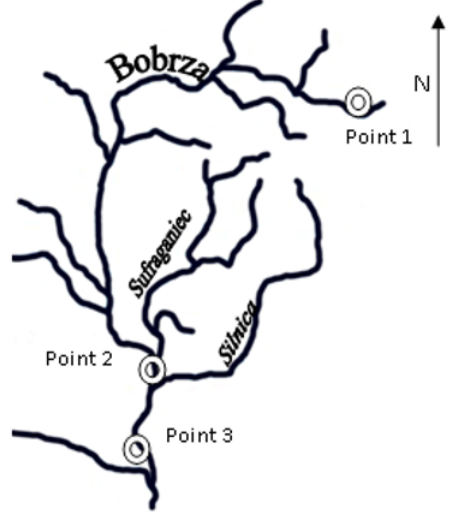
Figure 1. Sampling points in the Bobrza River